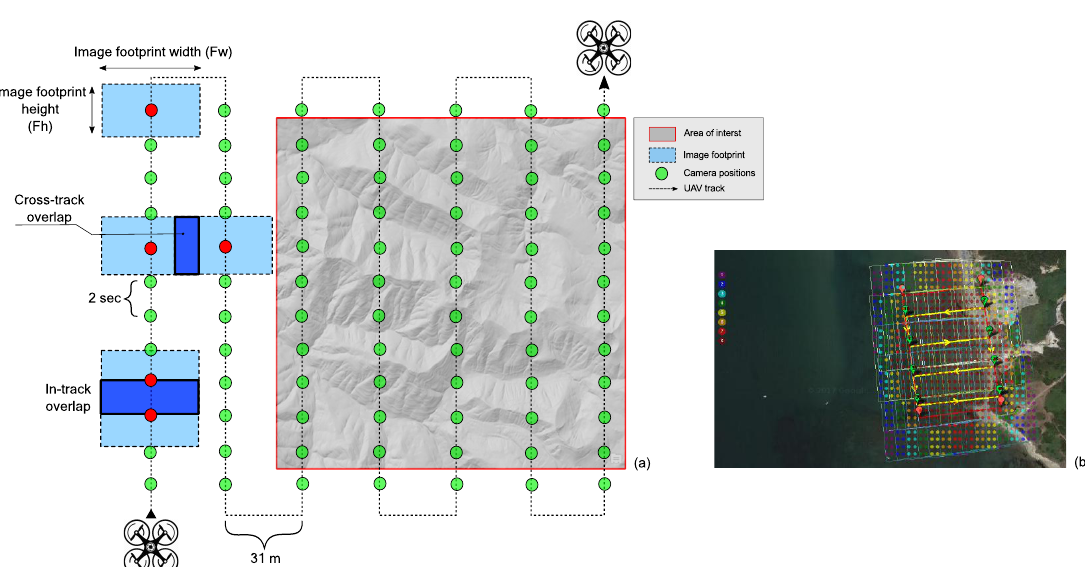
Figure 3. Schematic drawing displaying a typical aerial survey grid used during Unmanned Aerial Vehicle (UAV) mapping ( a ). Light blue rectangles indicate the image footprint and blue areas the cross-track and in-track overlaps, dotted black line represents the fly path and green dots within the flight path represent the location of the camera at the time of capturing each photograph. In ( b ) is represented a snapshot from the grid configuration panel in Mission Planner before the aerial acquisition was carried out in the S4